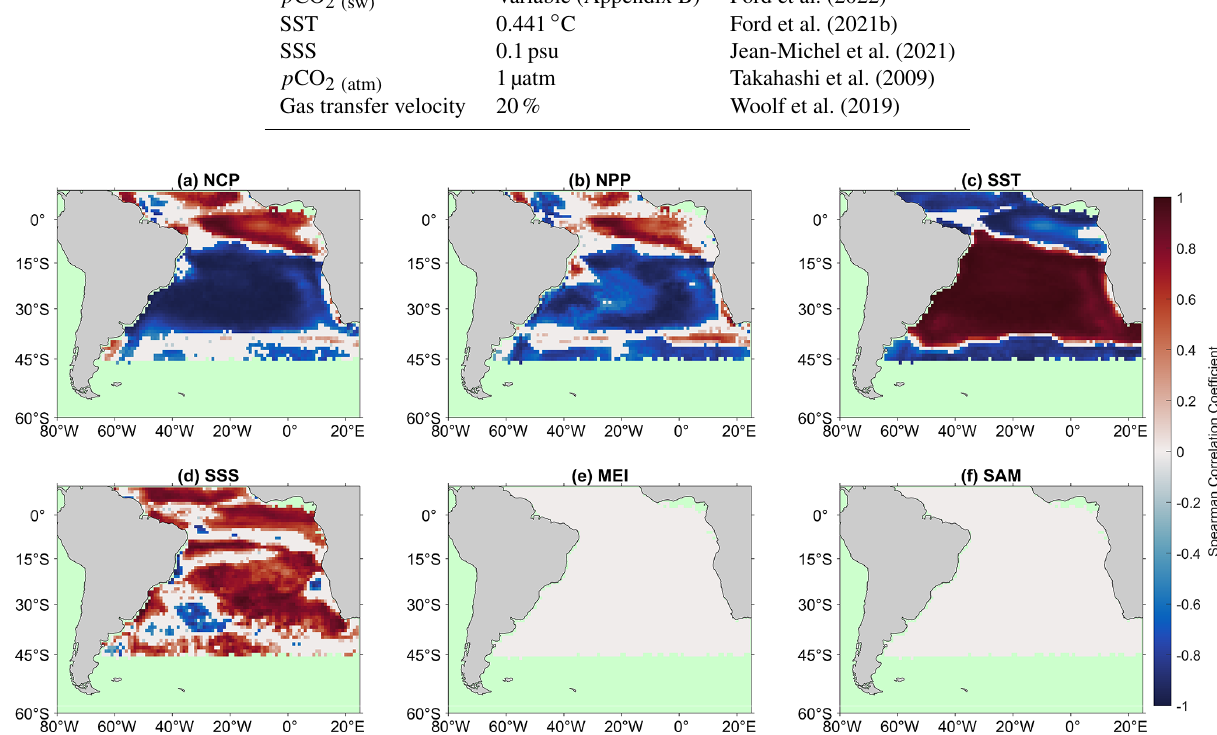
Figure 1. Significant Spearman correlations between the (cid:49)p CO 2 seasonal component of the X-11 analysis and (a) net community production (NCP), (b) net primary production (NPP), (c) sea surface temperature (SST), (d) sea surface salinity (SSS), (e) multivariate ENSO index (MEI), and (f) Southern Annular Mode (SAM) seasonal components. White regions indicate no significant correlations, and green regions indicate no analysis was performed due to missing satellite